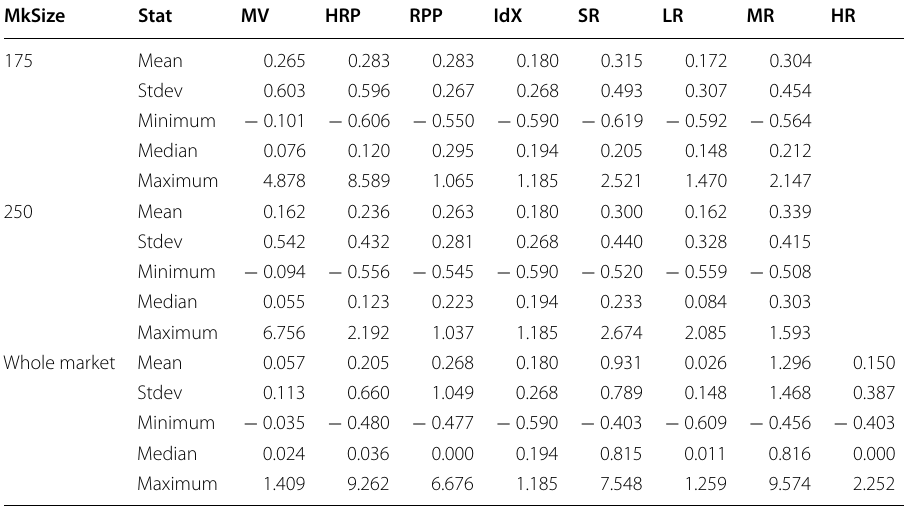
MV, mean-variance model; HRP, hierarchical risk parity; RPP, risk parity portfolio; IdX, Index CCI30; SR, sharpe ratio strategy; LR, low-risk strategy, MR, mean-risk strategy; HR, high-risk strategy